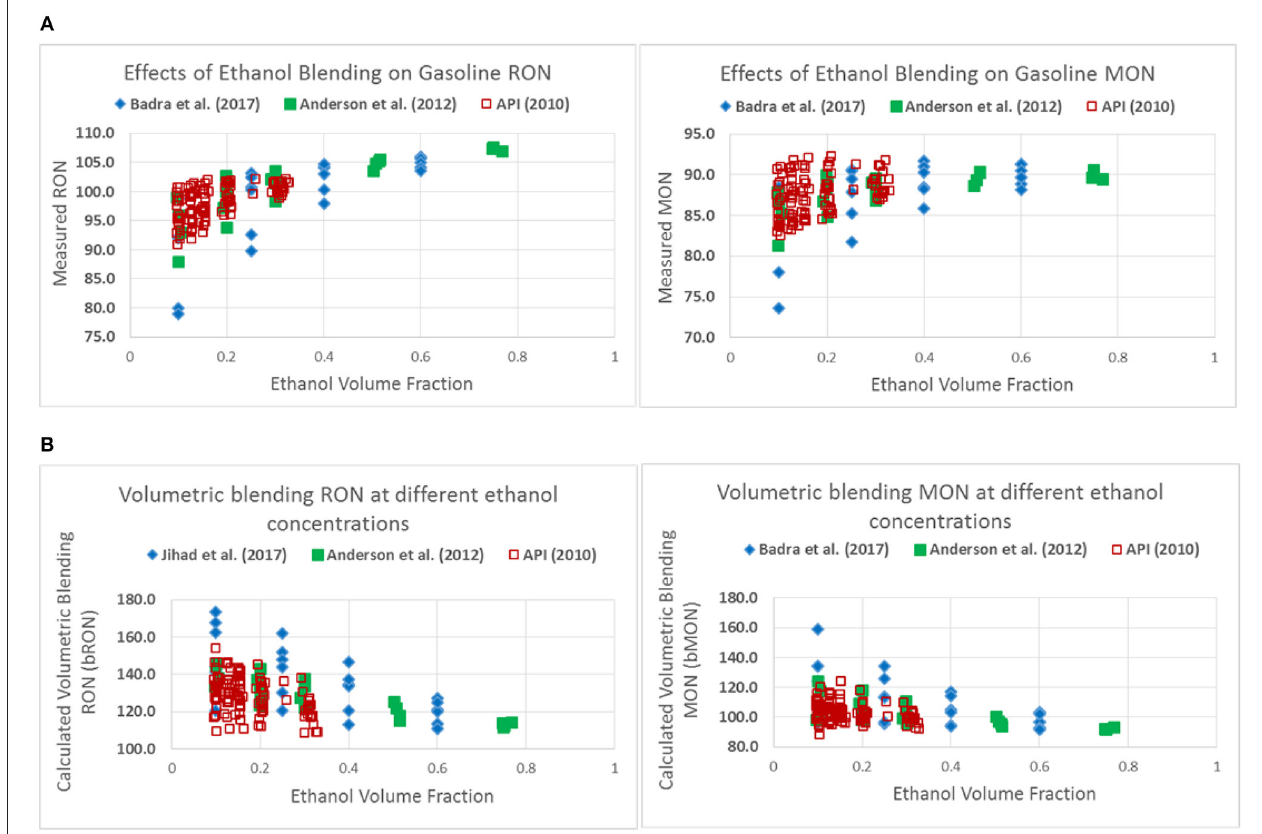
FIGURE 3 | Effects of ethanol-gasoline blend on the (A) measured RON and MON reported in the literature, and (B) the estimated volumetric blending RON and MON (bRON & bMON) calculated in this study.